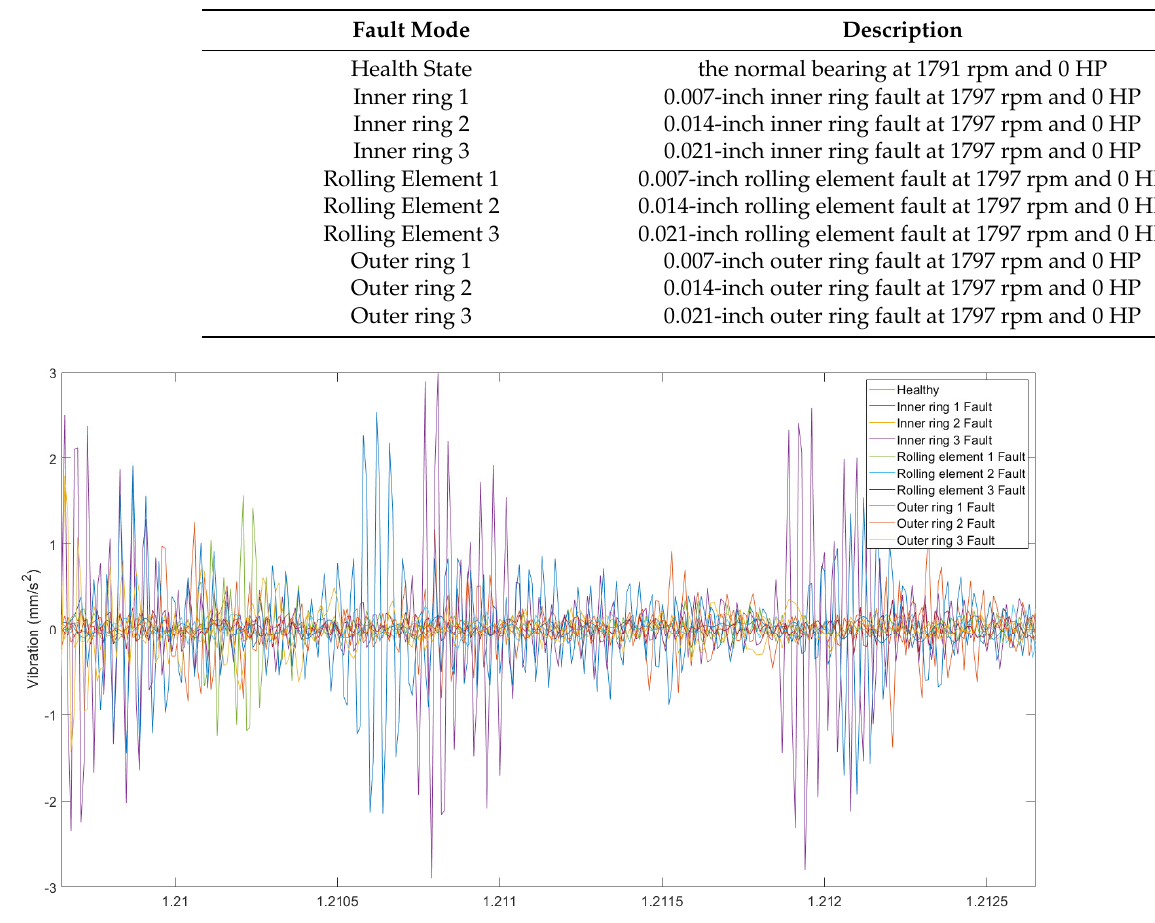
Figure 7. Vibration signals of the different faults in the CWRU dataset. Table 8. Confusion matrix for LWSN for the CWRU dataset.